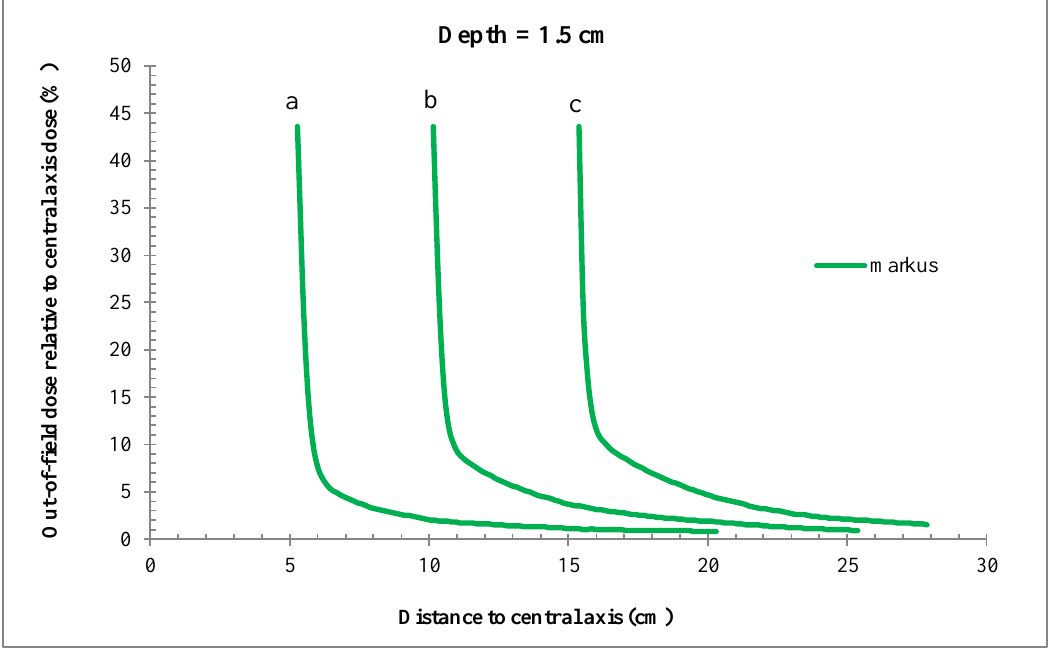
Figure 1.The variation in the out-of-field dose with distance to central axis for different field sizes a: 10×10 cm 2 , b: 20×20 cm 2 and c: 30×30 cm 2 using Markus ionization chamber